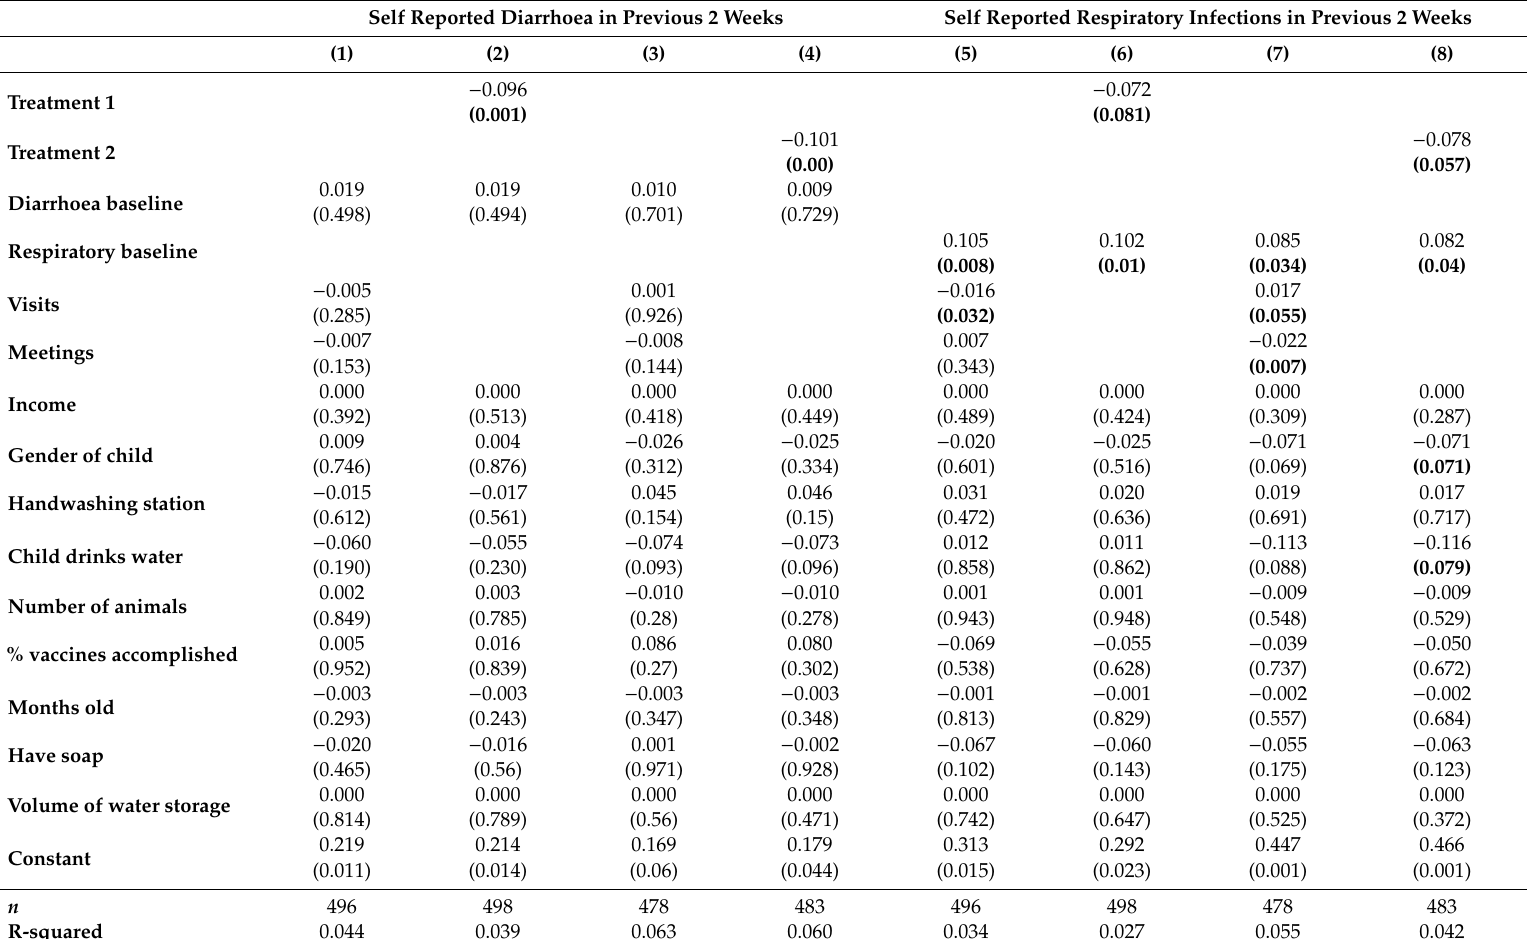
Table 6. A linear probability model predicting outcomes at end line ( p -values in parentheses; significant figures in